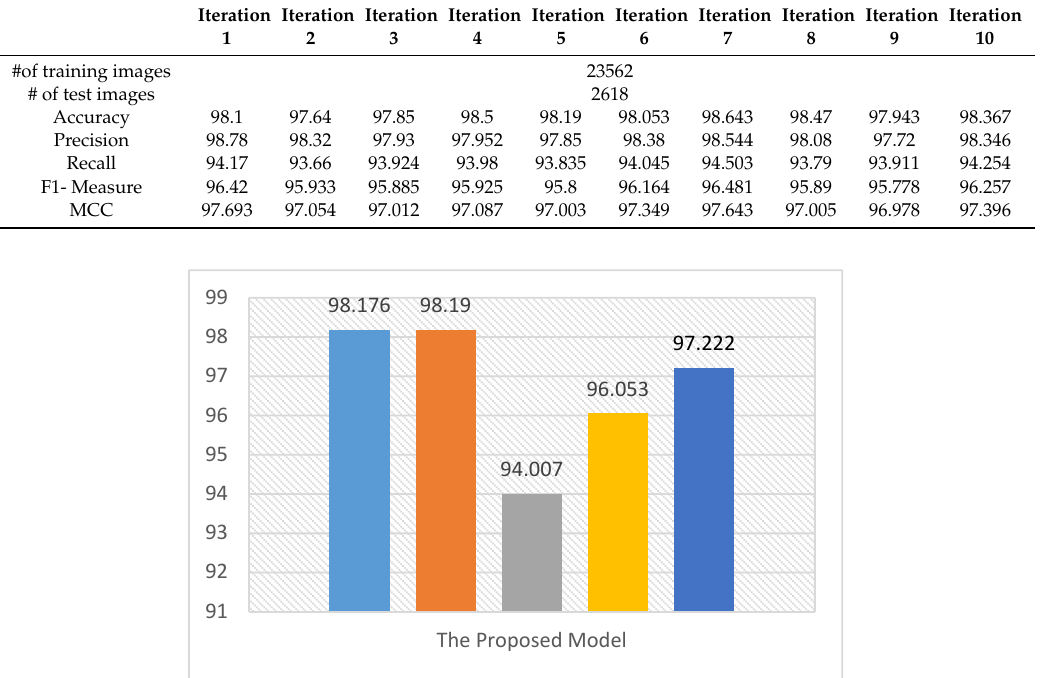
Figure 12. The 10-fold cross-validation average result on NIST 17 using the proposed model. Table 7. The detailed results of 10-fold cross-validation on the overall datasets.